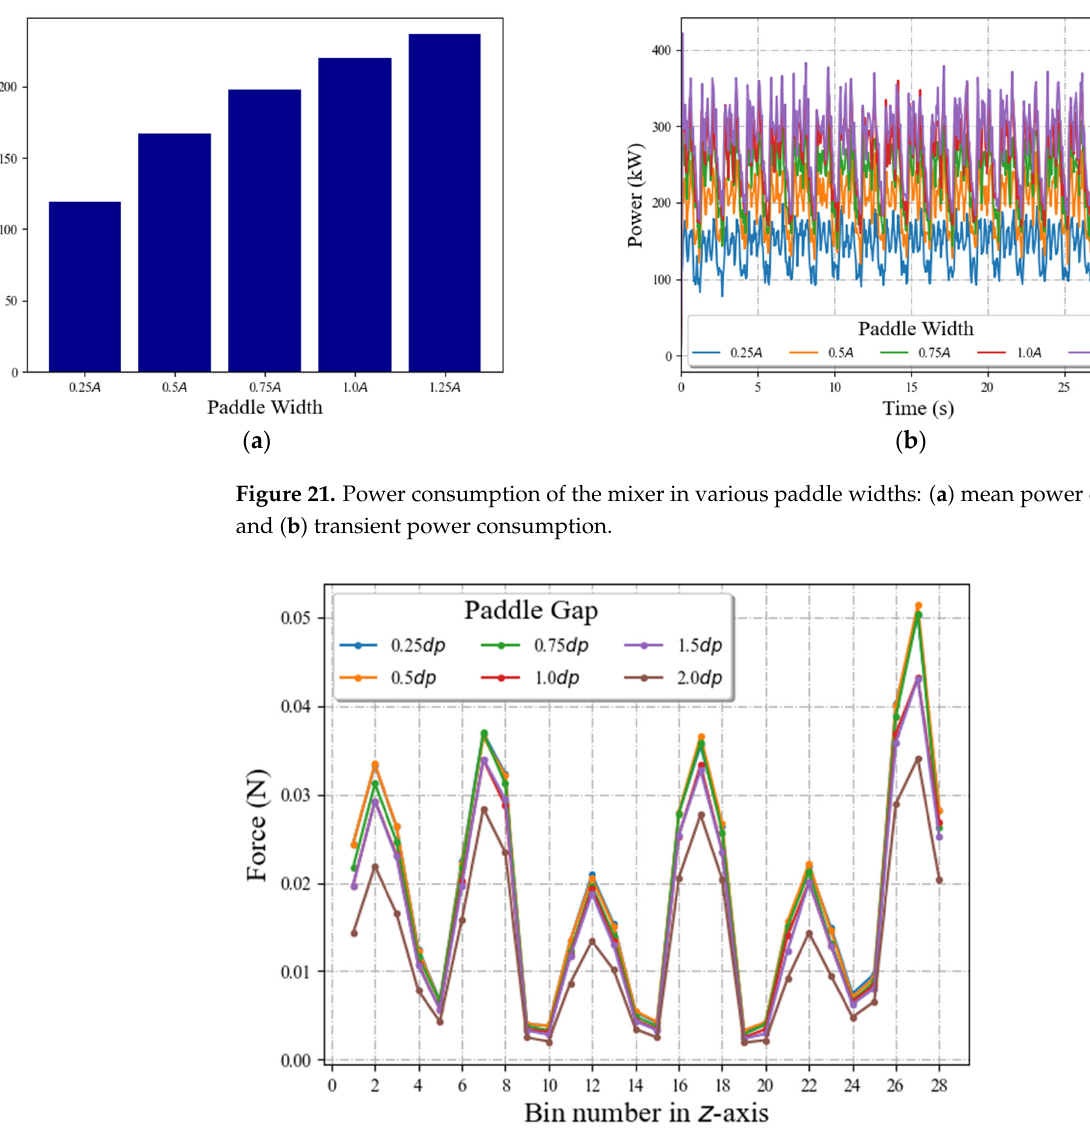
( d ) ( e ) Figure 20. Contour of time ‐ averaged forces acting on particles for various paddle width of ( a ) 0.25